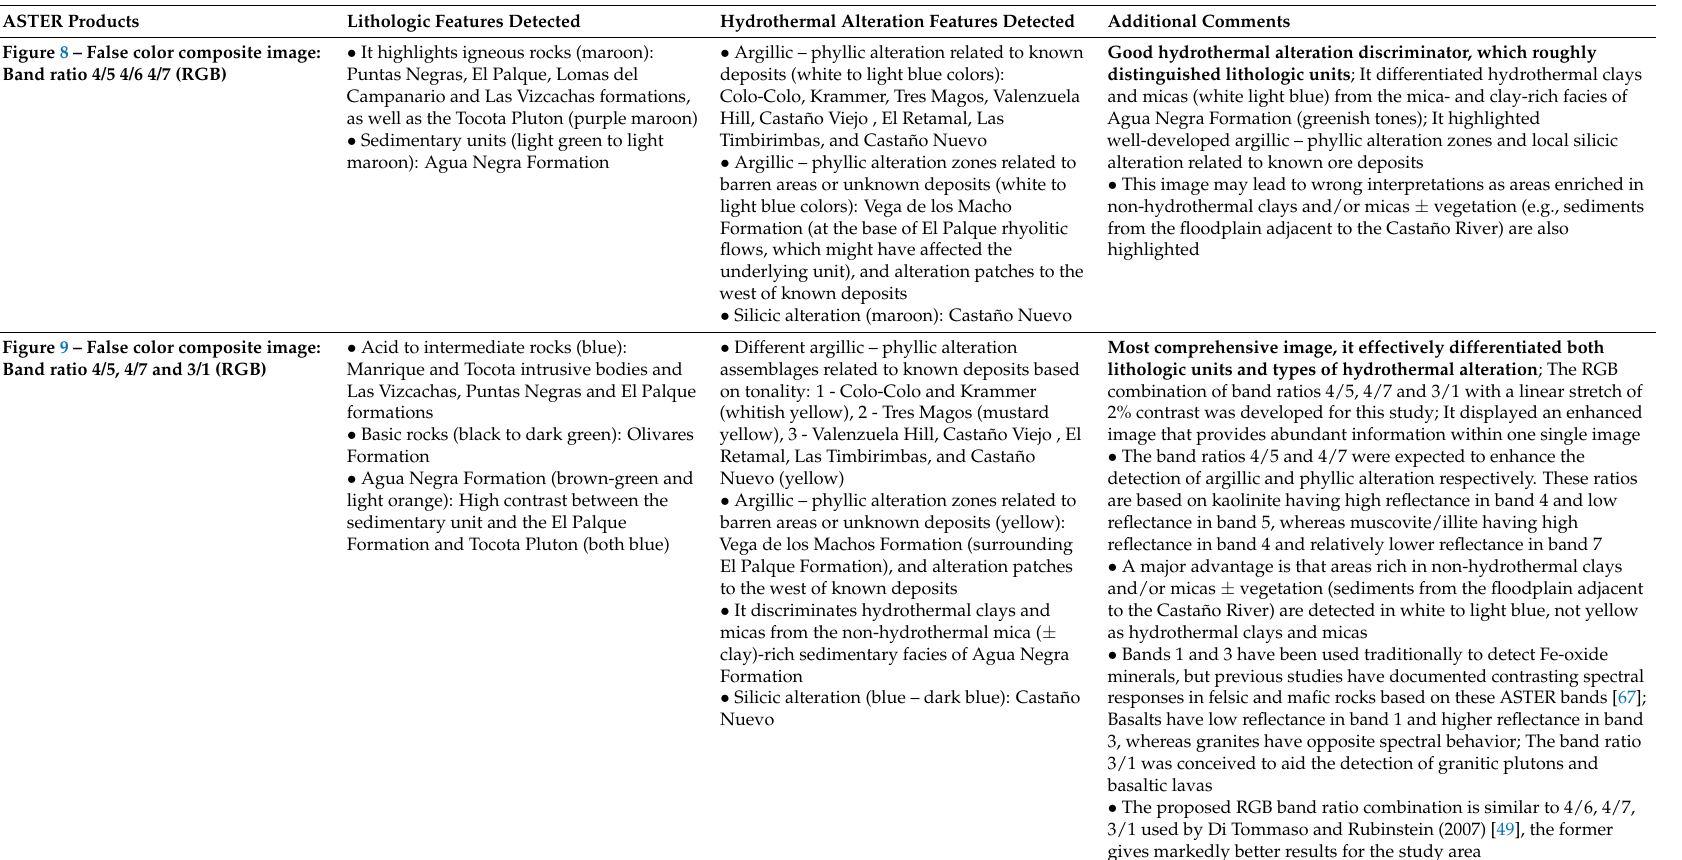
Figure 8 – False color composite image: Band ratio 4/5 4/6 4/7 (RGB)